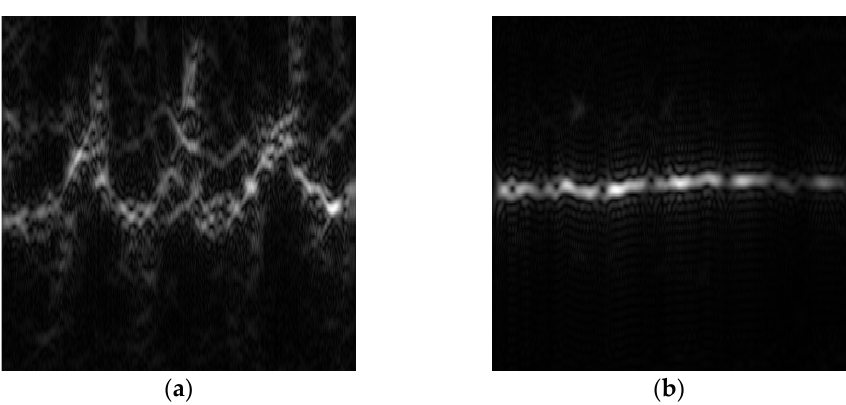
Figure 8. The time–frequency spectrograms of the measured data. ( a ) Pedestrian; ( b ) vehicle.